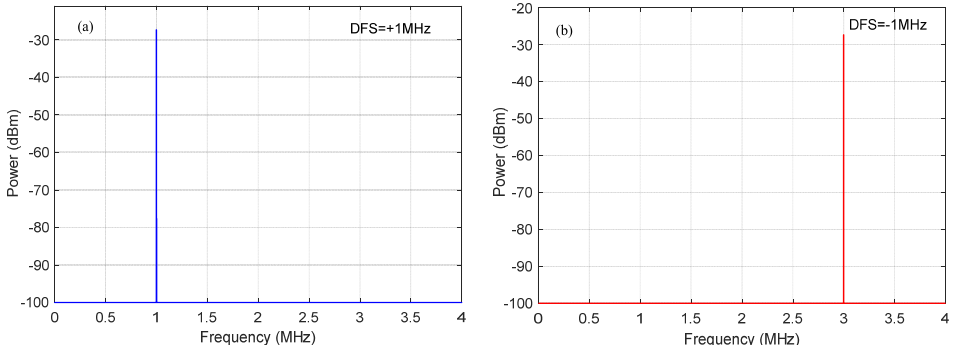
Figure 3. Electrical spectra in the lower branch for the Doppler frequency shifts at ( a ) +1 MHz and at ( b ) − 1 MHz.